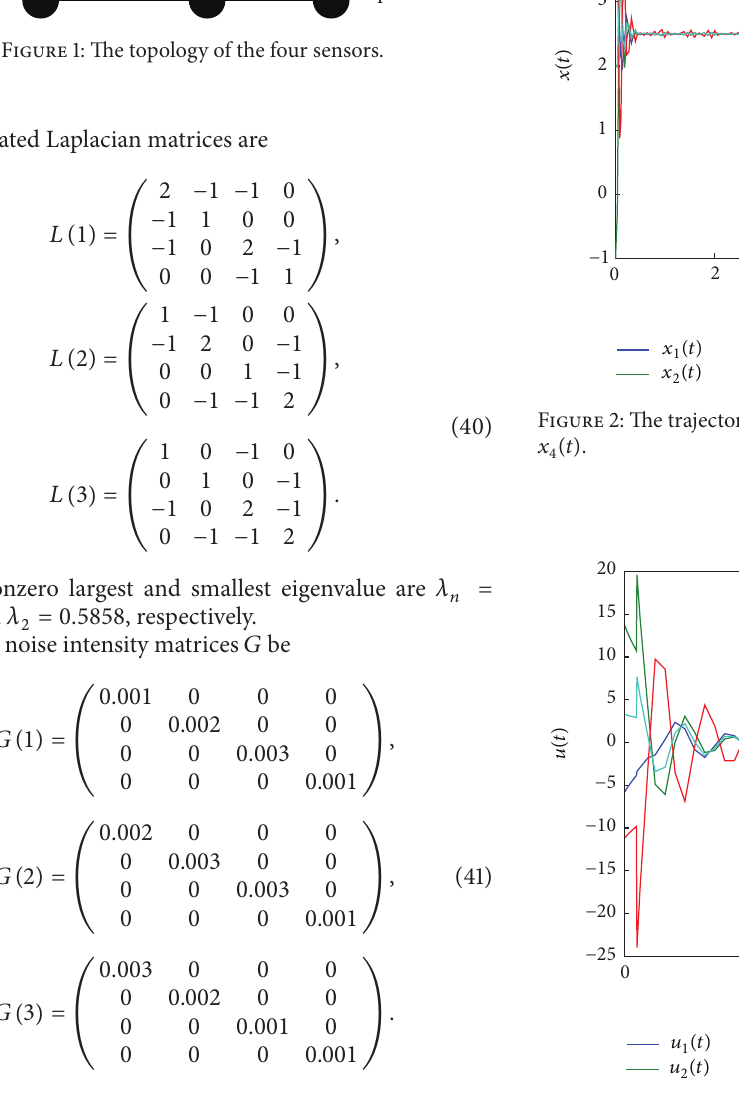
Figure 3: Control inputs for the sensors.